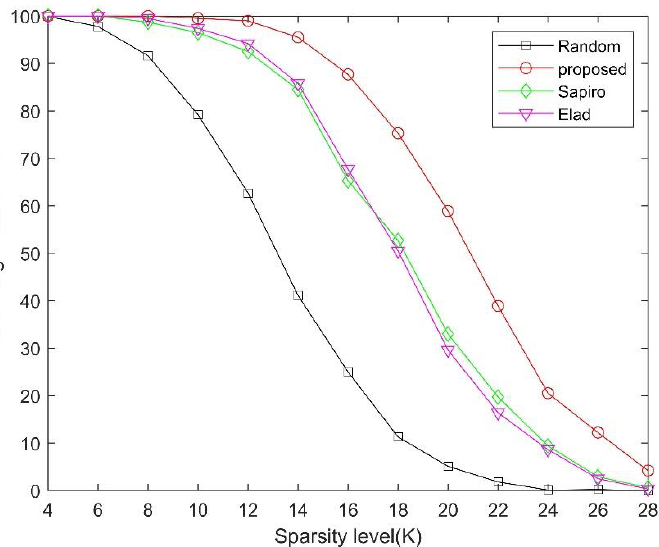
Figure 4. Comparison of the reconstruction performances using various measurement matrices under the same measurements M = 64.